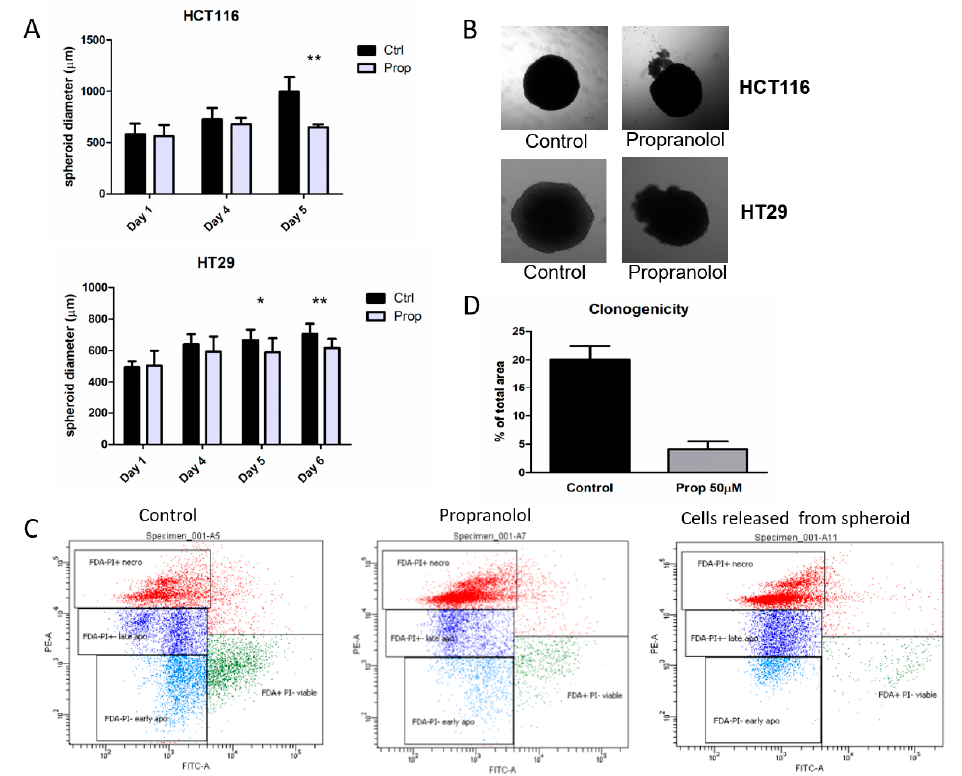
Figure 3. Propranolol influences adaptation to hypoxic microenvironment, reduces growth of spheroids and increases apoptosis in HCT116 and HT29 3D models. ( A ) Graph of the growth of HCT116 and HT29 spheroids in time, with/without propranolol treatment (50 µM). Spheroids were cultivated individually and regularly measured using a Zeiss Axiovert 40 CFL microscope.